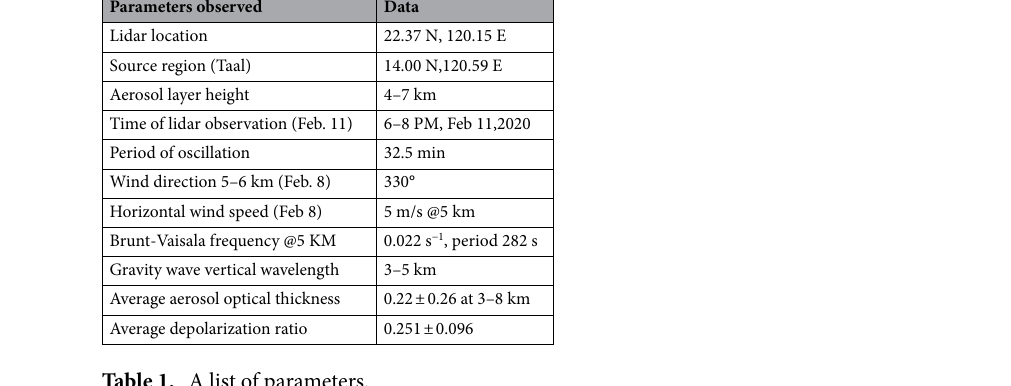
Table 1. A list of